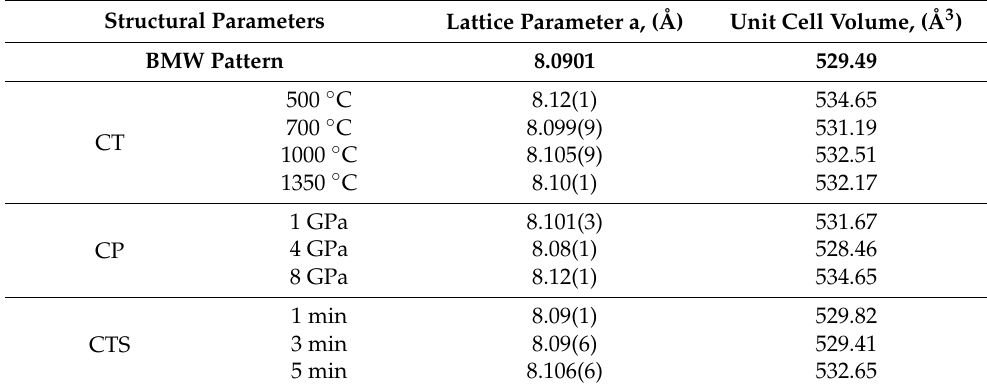
Table 3. Comparison of the crystallographic structure parameters of ceramic materials with the pattern. Structural